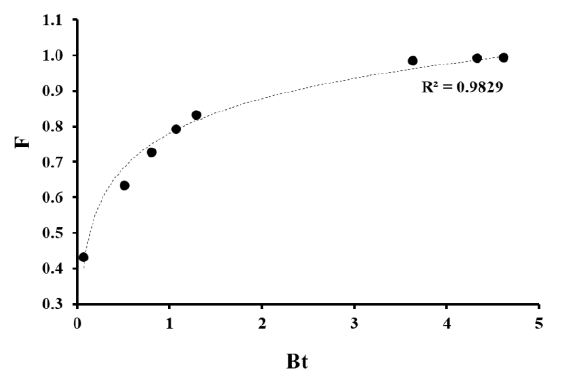
Figure 5. Change of equilibrium attainment degree (F) depending on Bt during Pb 2 + ion sorption.